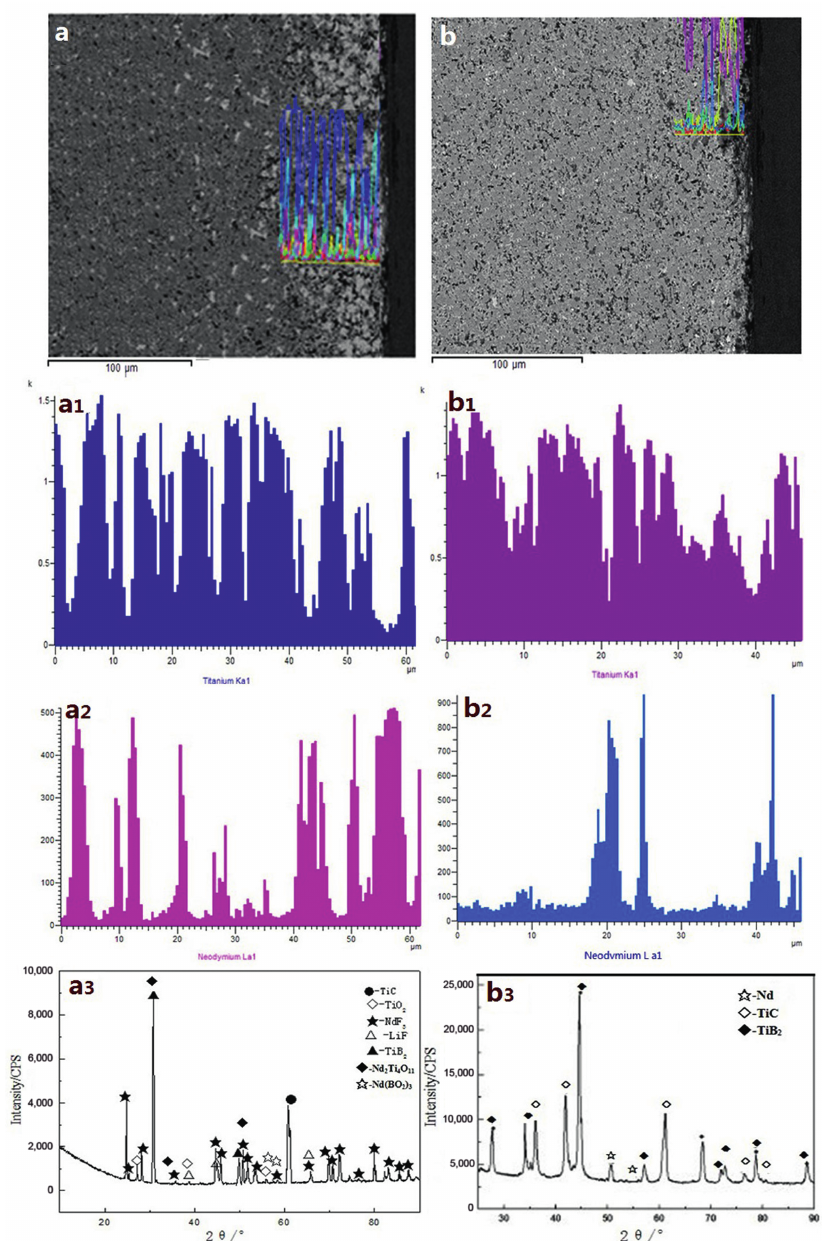
Figure 3: Micrographs and EDS analysis of the cross sections close to the penetration front of the TiB 2 /TiC composites exposed to (a) molten NdF 3 – Nd 2 O 3 – LiF salts and (b) liquid Nd; as well as the element distributions (a 1 , a 2 ) corresponding to molten NdF 3 – Nd 2 O 3 – LiF salts and (b 1 , b 2 ) corresponding to liquid Nd (a 3 , b 3 ) showing the XRD results of the corresponding cross sections after